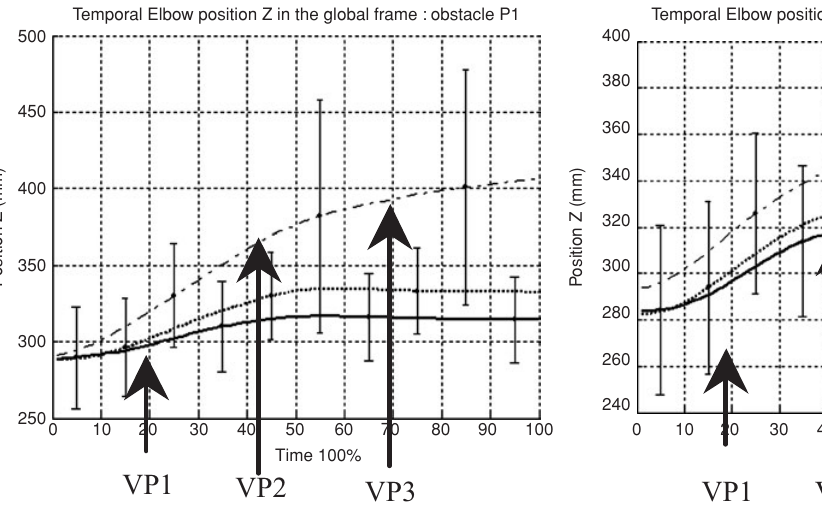
Figure 3 Temporal elbow elevation and via point specification.